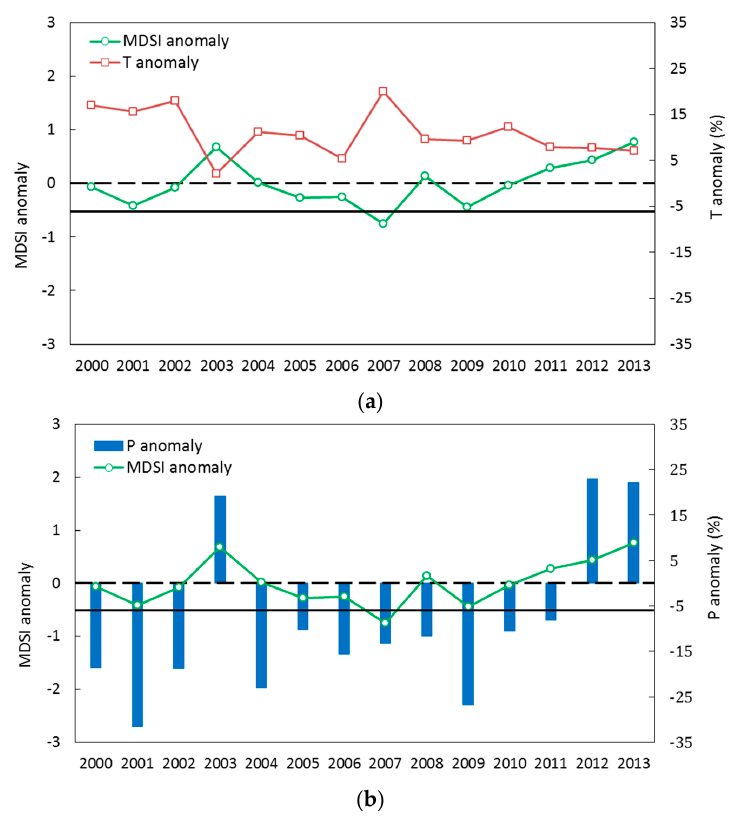
Figure 5. Time series for the MDSI anomaly with different climatological variables over the sixteen stations during 2000–2013: ( a ) anomalies of MDSI (green open circles) and T (red opened squares); and ( b ) anomalies of MDSI (green open circles) and P (blue bars). The horizontal lines show that the MDSI anomaly value is − 0.5 or less for drought conditions, whereas horizontal dashed lines show the percentage deviation values of T (0.0 or above) and P (0.0 or less) for drought condition.